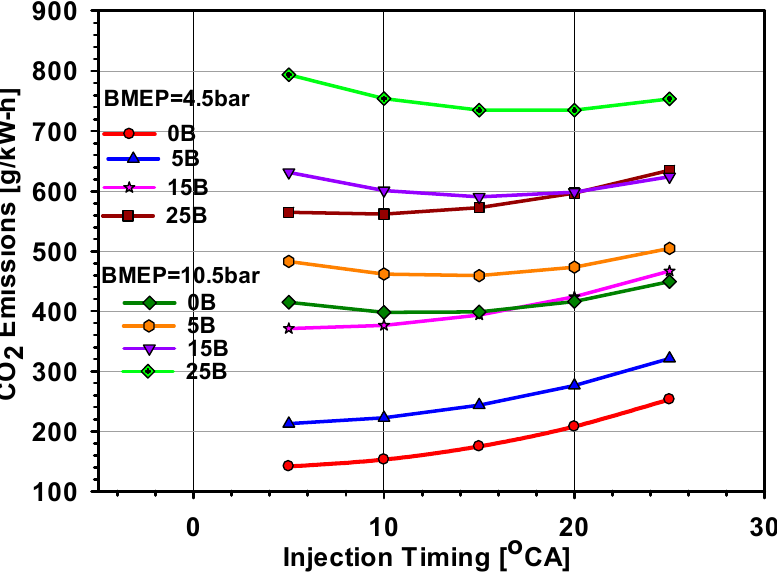
Figure 9. Variation of CO 2 emissions.